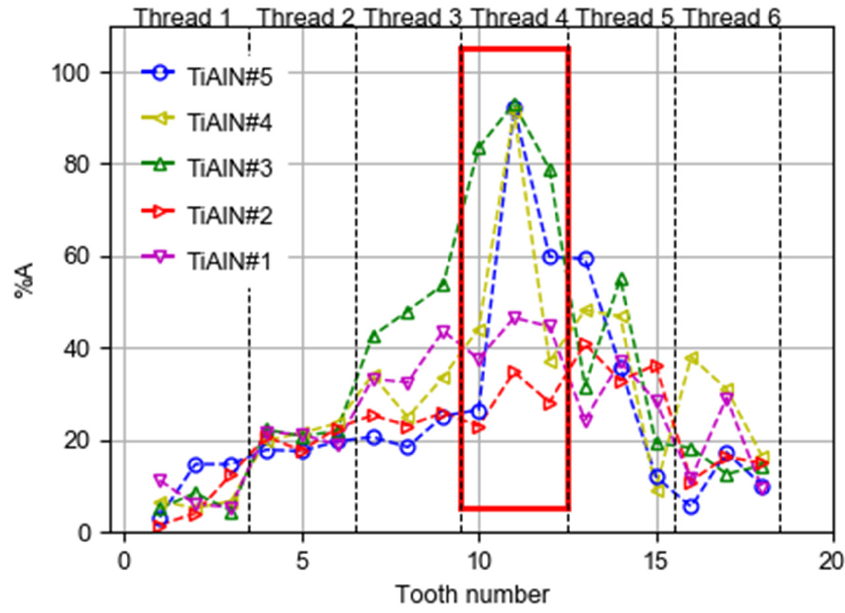
Figure 16. %A parameter evolution on the teeth of every TiAlN coated taps.